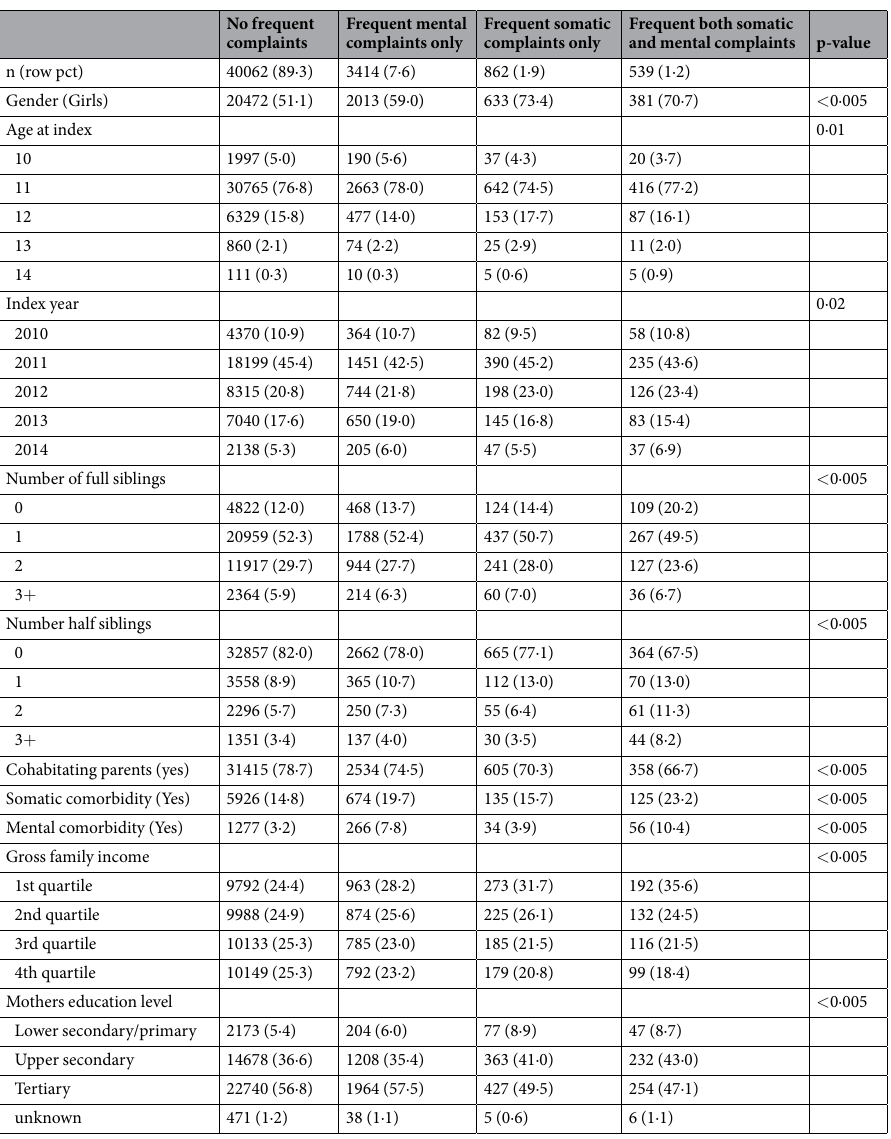
Table 2. Characteristics of participants dependent on the experience of self-reported frequent non-specific health complaint in pre-adolescents. Presented as n